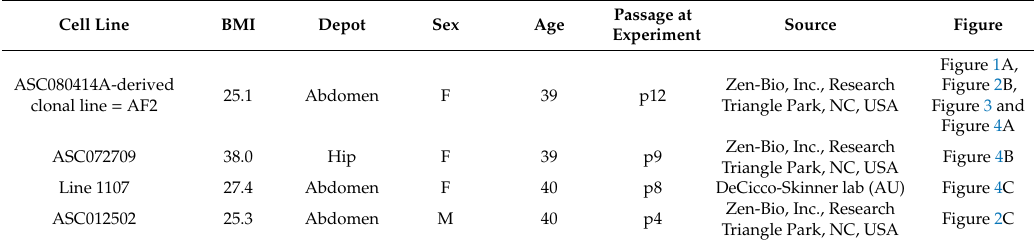
Table 1. Cell lines used in the